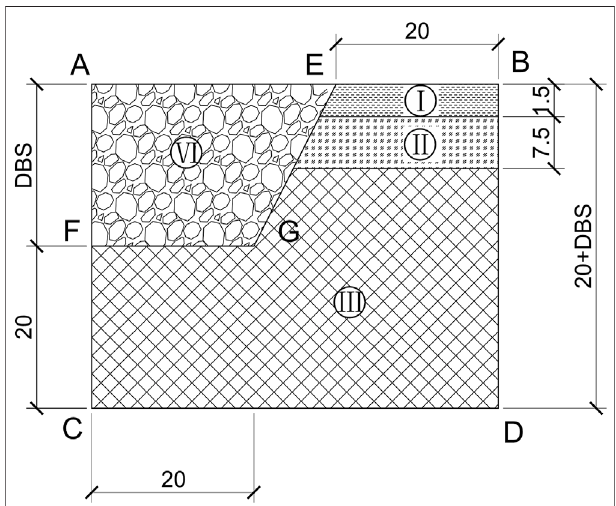
FIGURE4| Physicalmodelofthepitback fi lldomainintheGulianhestrip coalmine in the Hola Basin in northern Da Xing ’ anling Mountains, Northeast